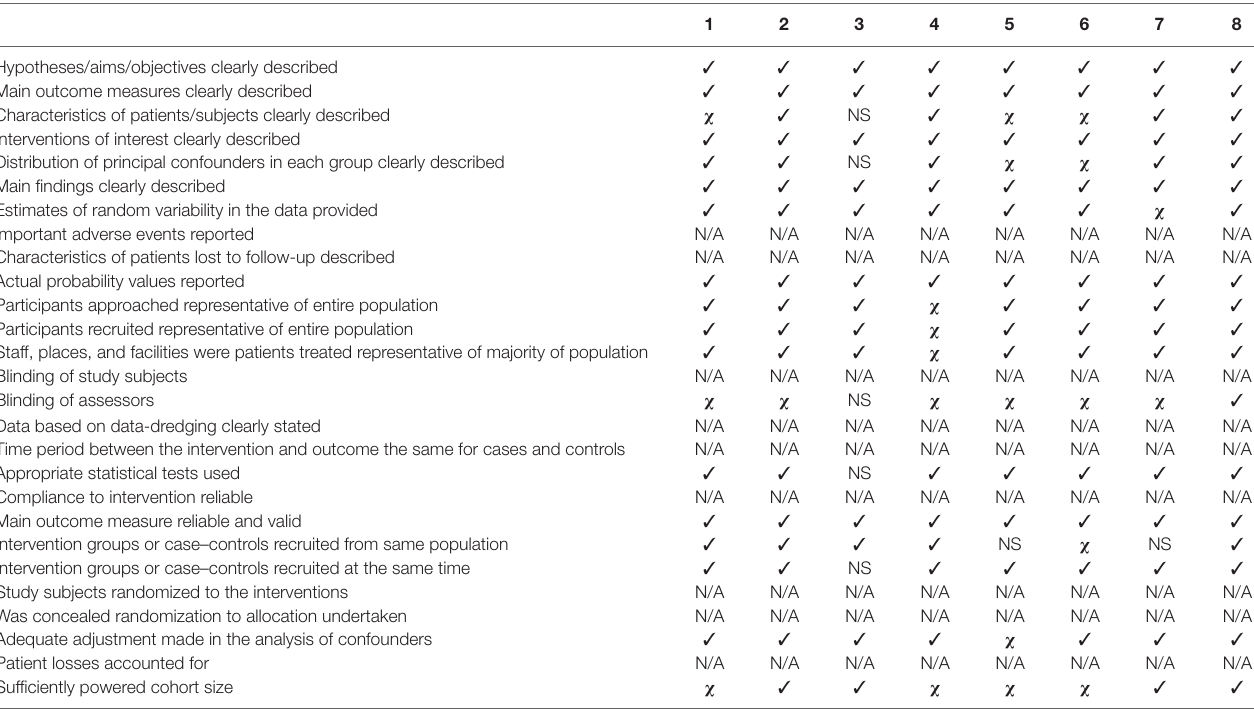
TaBle 2 | Down and Black’s appraisal.